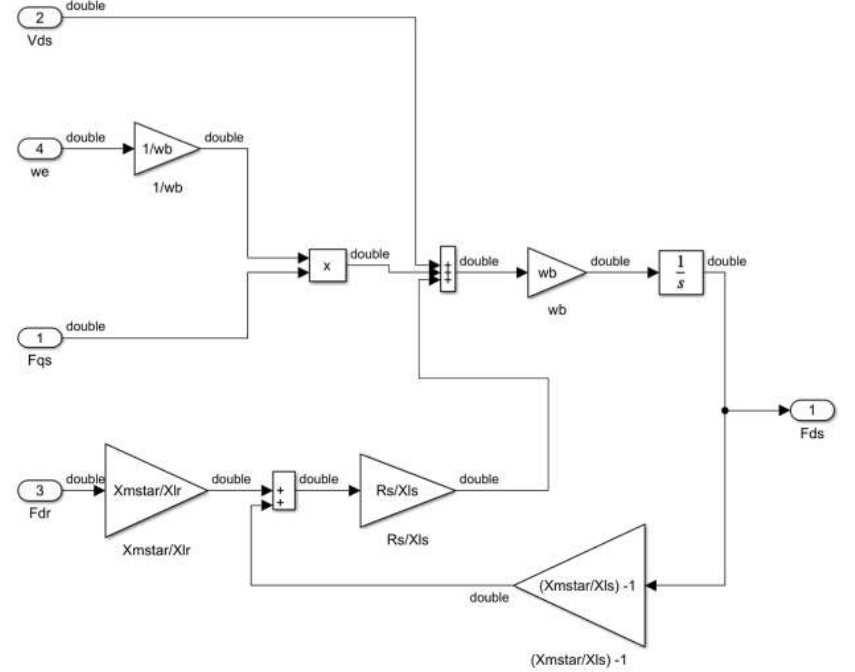
Figure 8. Simulink block that solves the differential equation of the F ds flow (Xmstar is the total magnetizing reactance χ * lm ).